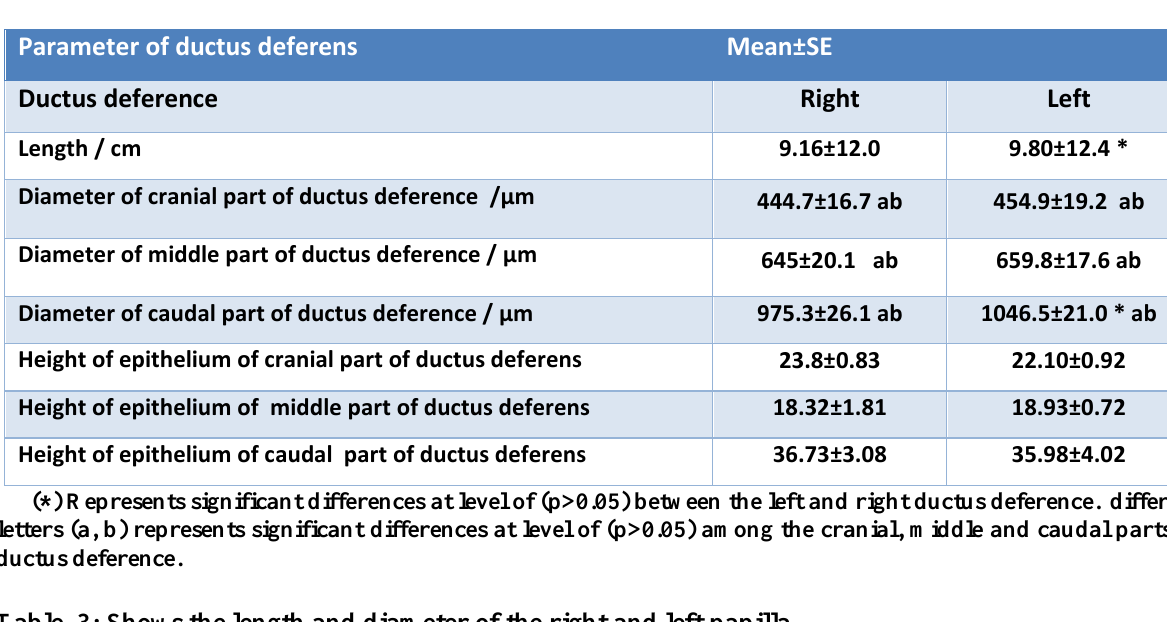
Table, 3: Shows the length and diameter of the right and left papilla.